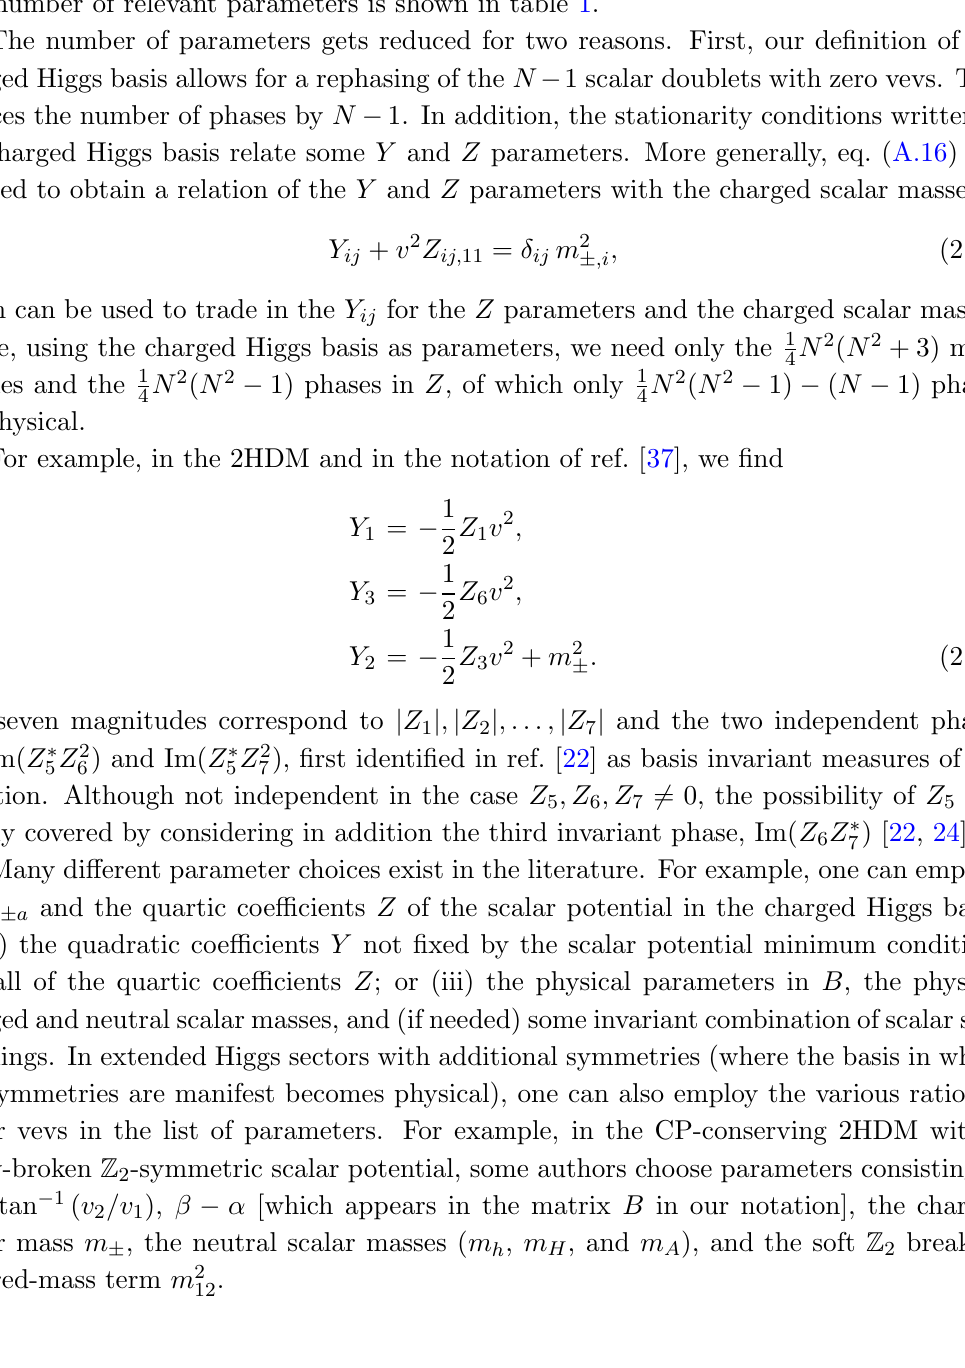
Table 1 . Number of parameters in the Y and Z coe(cid:14)cients of the Higgs potential. The number of relevant parameters is shown in table